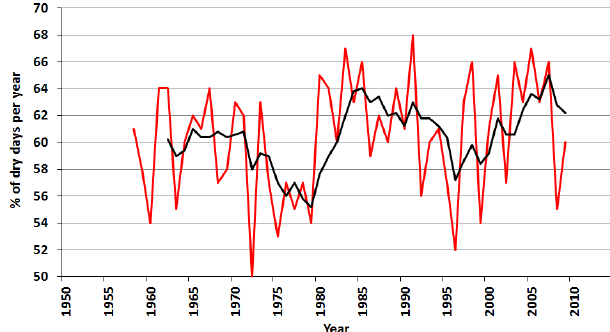
Fig. 2. Relation between beginning of manual and automatic meteo- rological measurements at high altitude meteorological stations (all above 1300m) world-wide: Alps, Massif Central, Anatolia, Cauca- sus, Altai, Himalaya, Canadian and US Rockies, Owyhee Moun- tains (USA) and Rwenzori Range (Africa). The two discharge sta- tions are Vernagt Glacier (Austria) and Piave